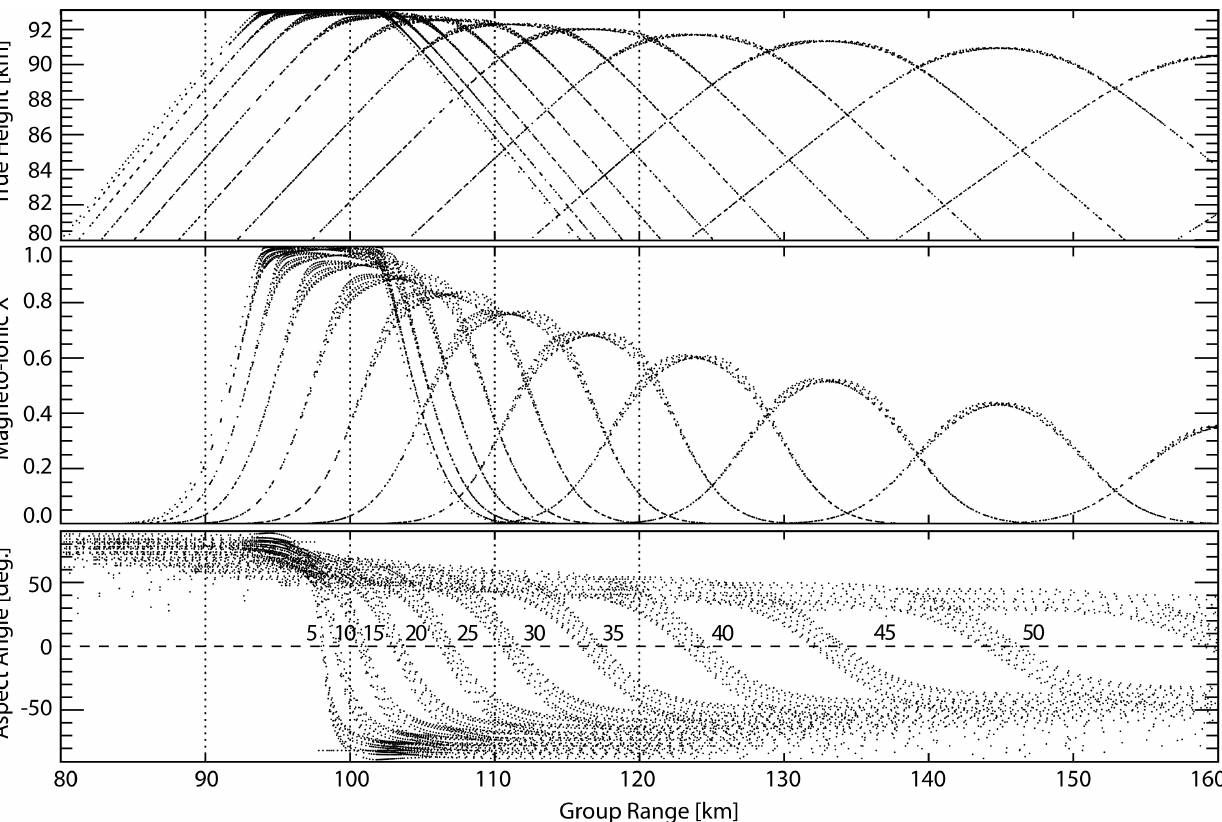
Fig. 11. Results of three-dimensional ray tracing through a Chapman E-layer for a sounding frequency of 2MHz at Casey station. The layer is parameterized by a peak height, critical frequency and scale height values of 105km, 4MHz and 7km, respectively. The geomagnetic field, IGRF 2000, has been included in the simulation. The ray true heights, magneto-ionic X parameters and magnetic-aspect angles are plotted against the group ranges for zenith angles ranging from 5 ◦ to 55 ◦ in 5 ◦